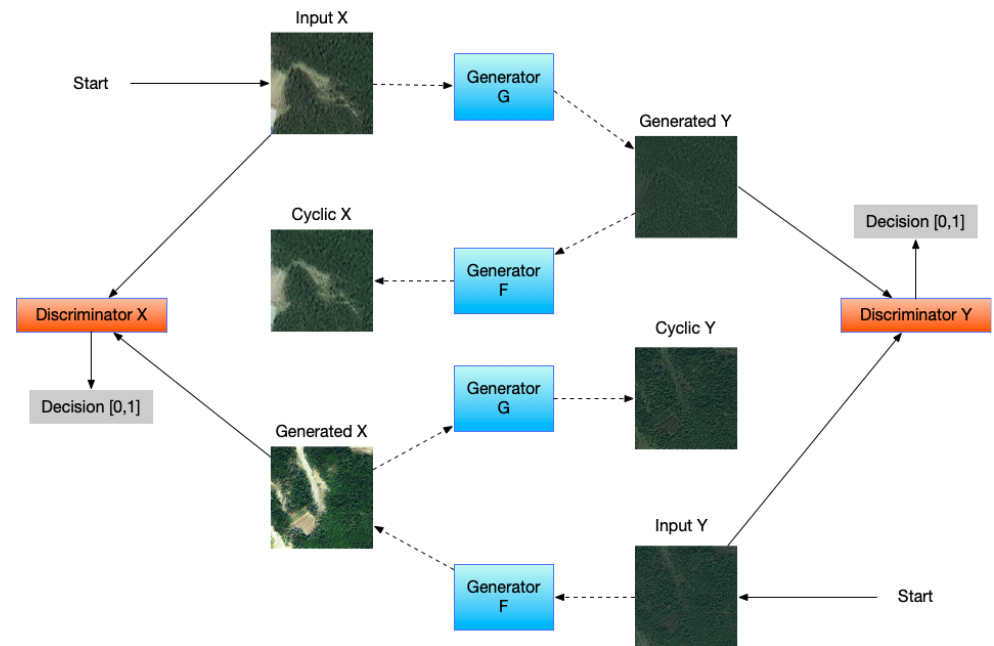
Figure 3. Flow chart of cycleGAN training.